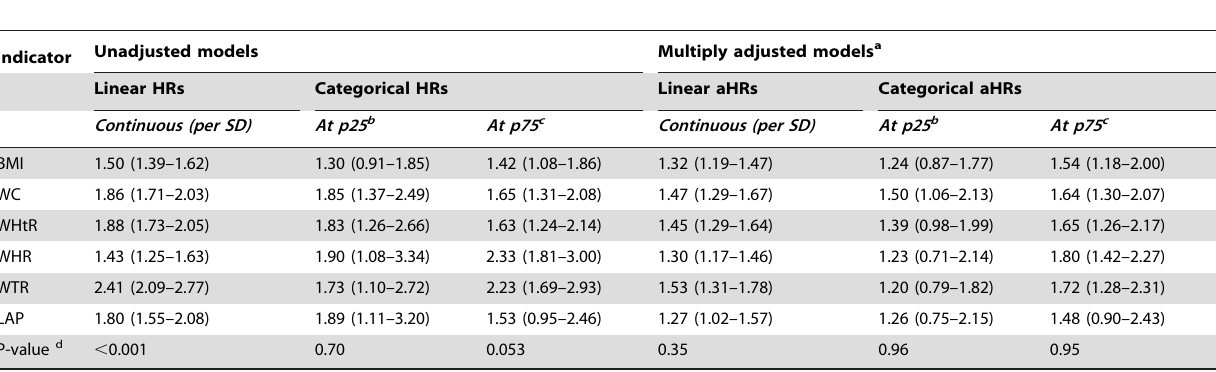
Table 4. Hazard ratios (95% CI) for all-cause mortality associated with 6 adiposity indicators presented as linear continuous models and categorical models at boundaries p25 or p75 for US nonelderly